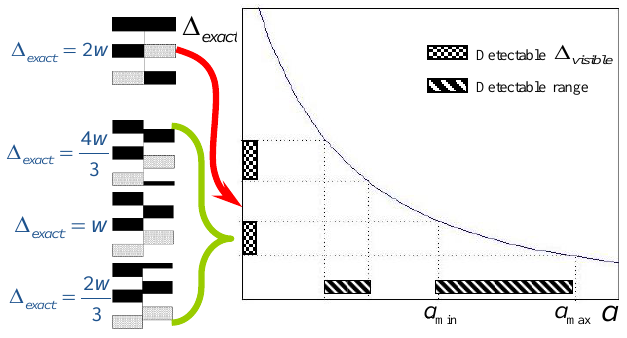
∆ exact vs. detectable range [ a min , a max ] .